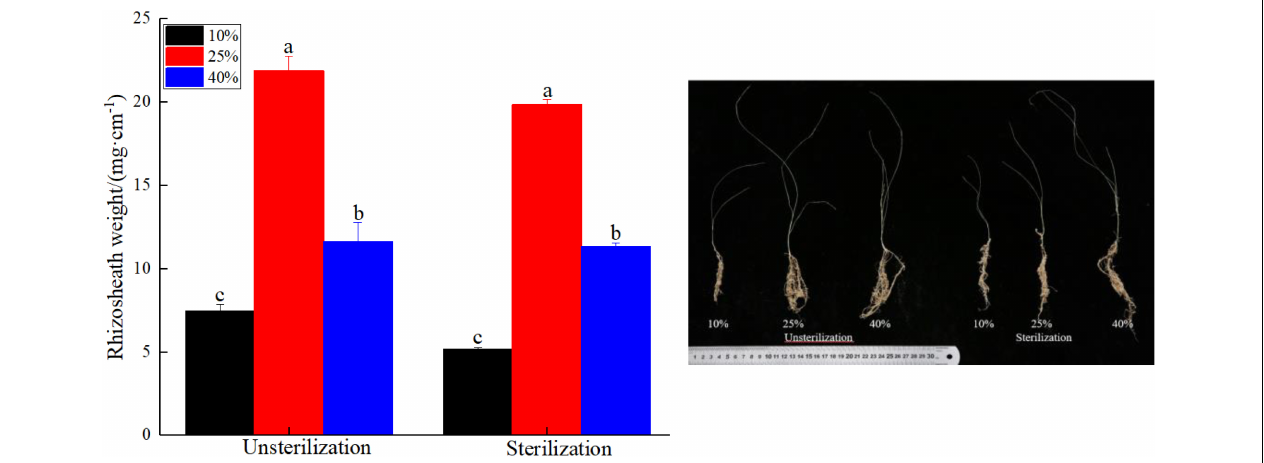
FIGURE 1 | The differences in rhizosheath weight due to different soil and moisture treatment. Different lowercase letters in the figure indicate significant differences ( p <